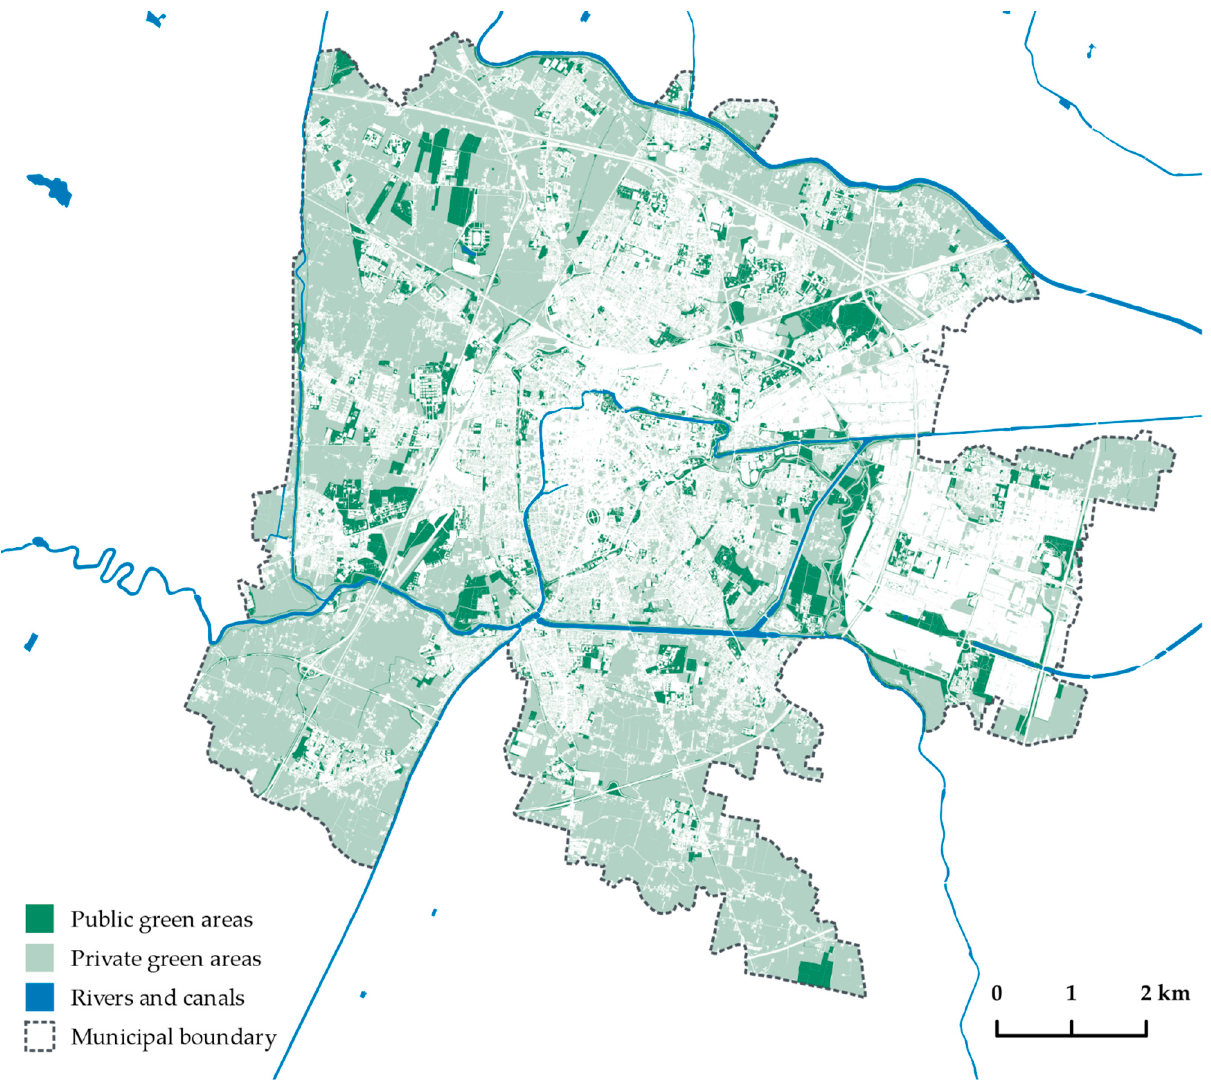
Figure 9. Map of public and private urban green spaces in Padua.